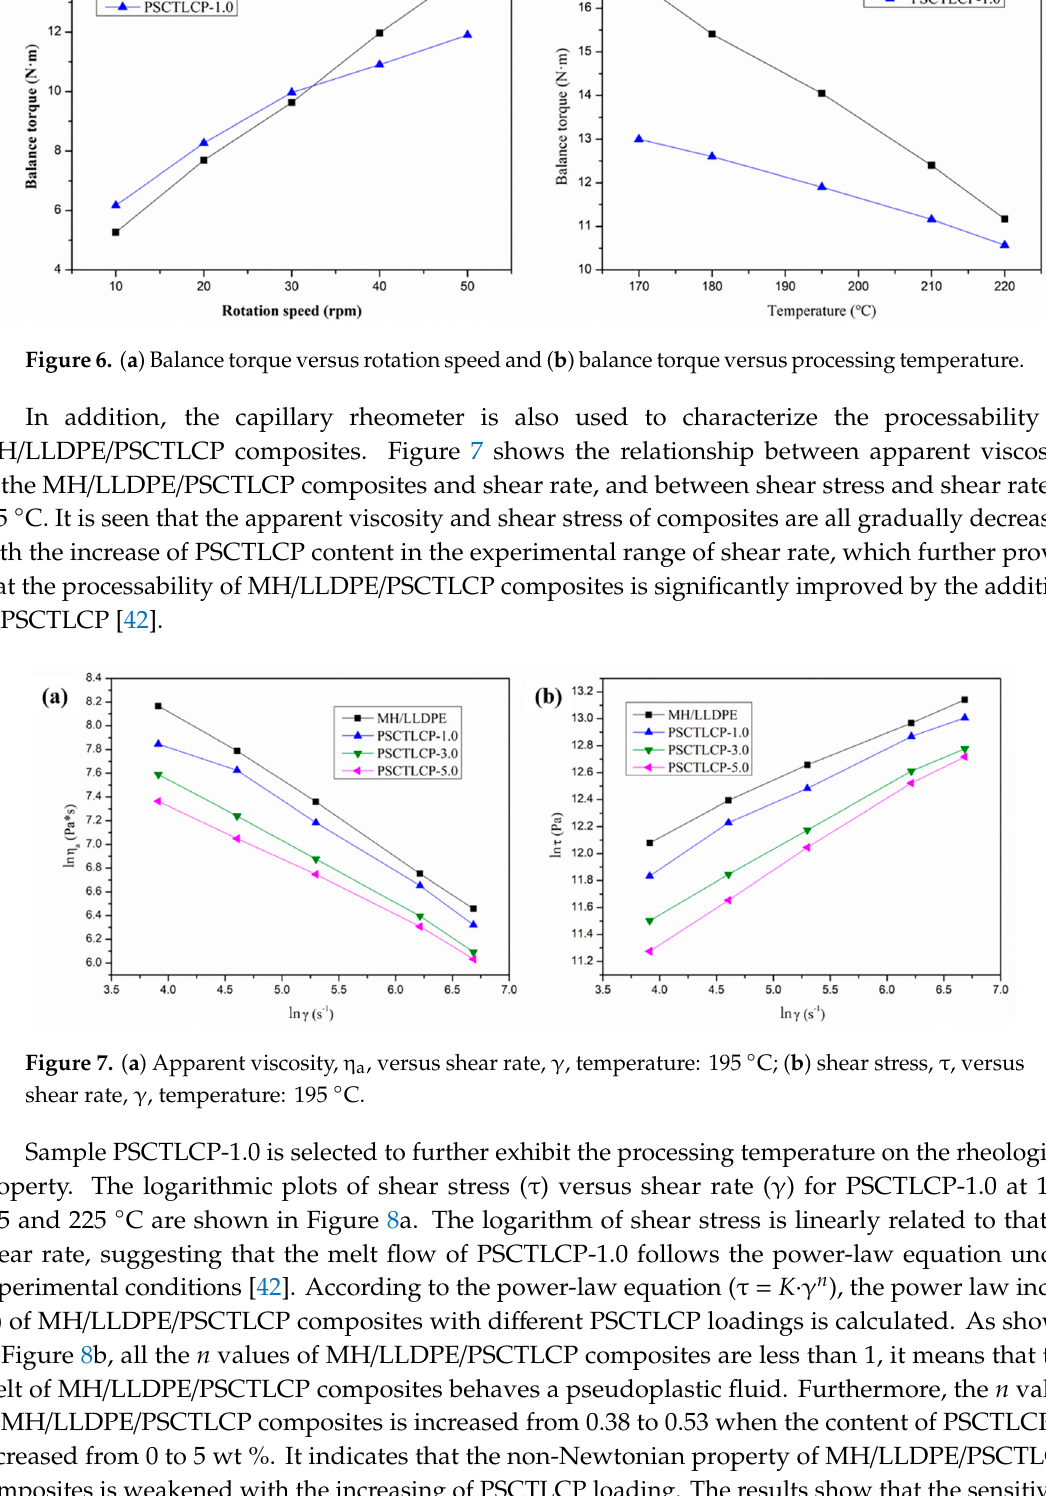
Figure 5. Torque versus time of MH/LLDPE/PSCTLCP composites with various PSCTLCP loading.